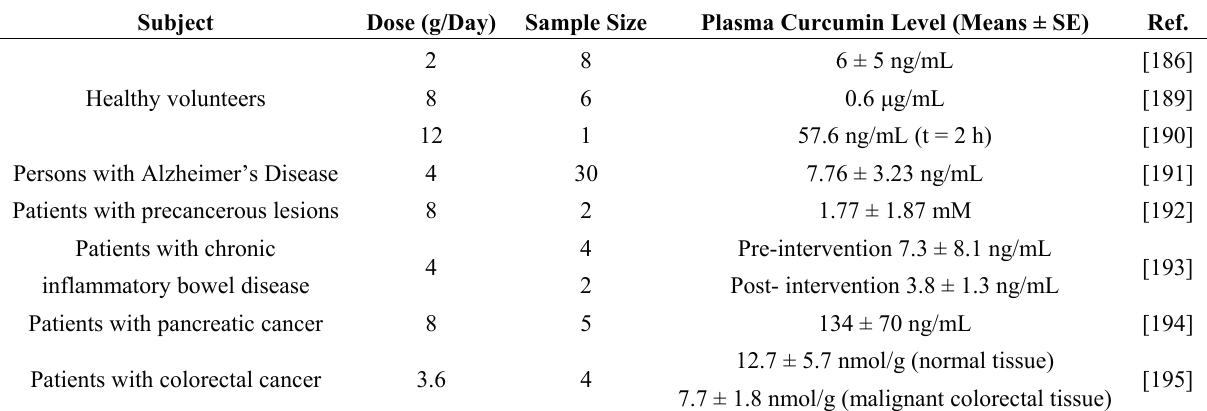
Table 1. Previously reported blood curcumin concentrations in